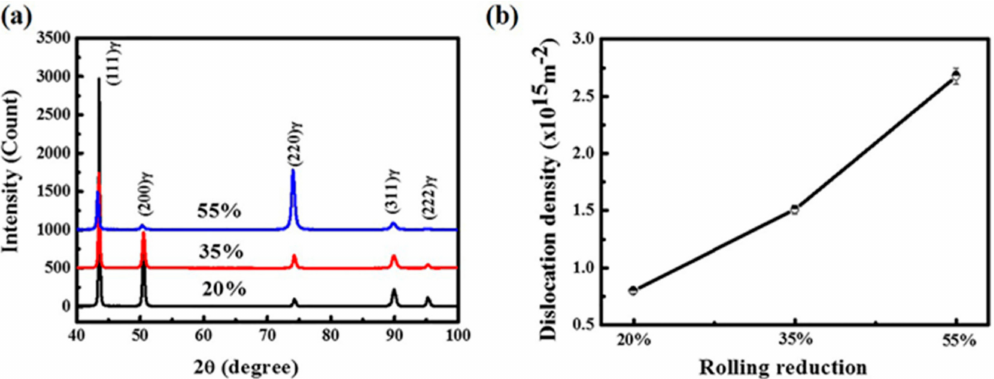
Figure 2. X-ray diffraction patterns of the specimens ( a ) and variation of dislocation density with increasing warm rolling degree ( b